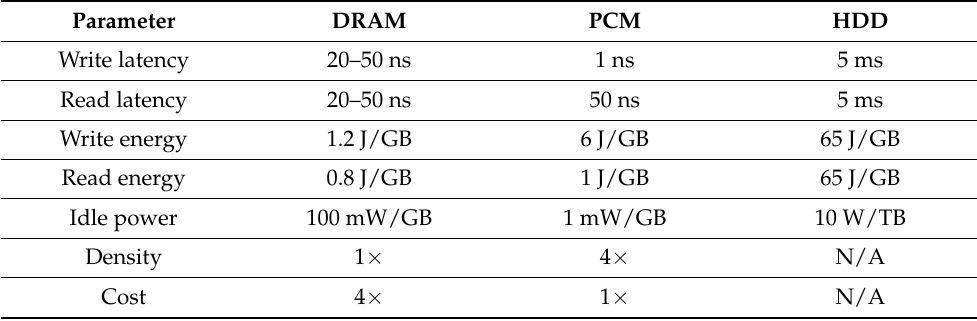
Table 4. Simulation